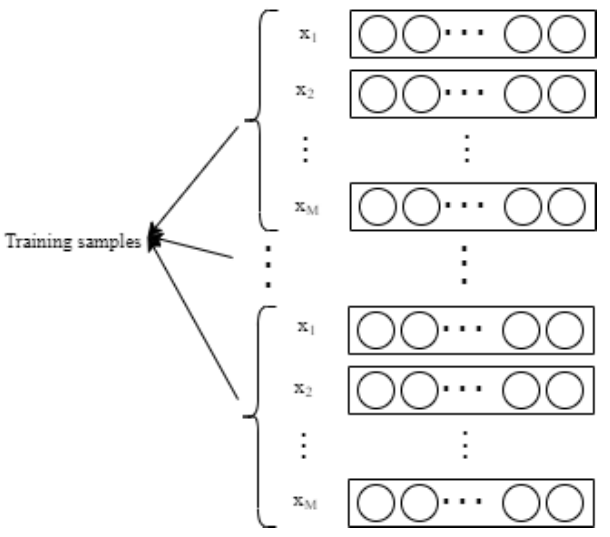
Figure 11. Data augmentation of the PRPD data. Table 2. Details of proposed SANPD.